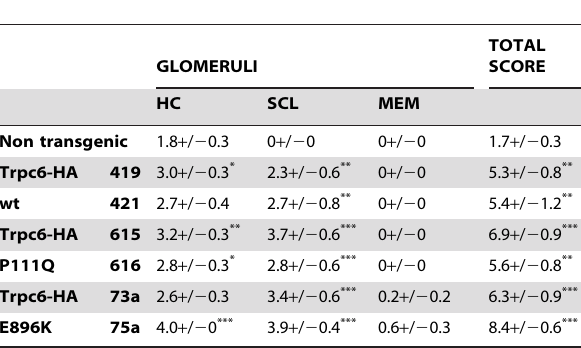
Table 1. Histopathologic injury scores from kidneys of non transgenic and transgenic mice at 5–9 months of